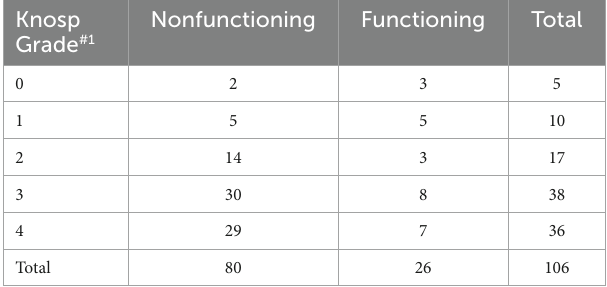
TABLE 1 Distribution of patients based on the tumor grade.